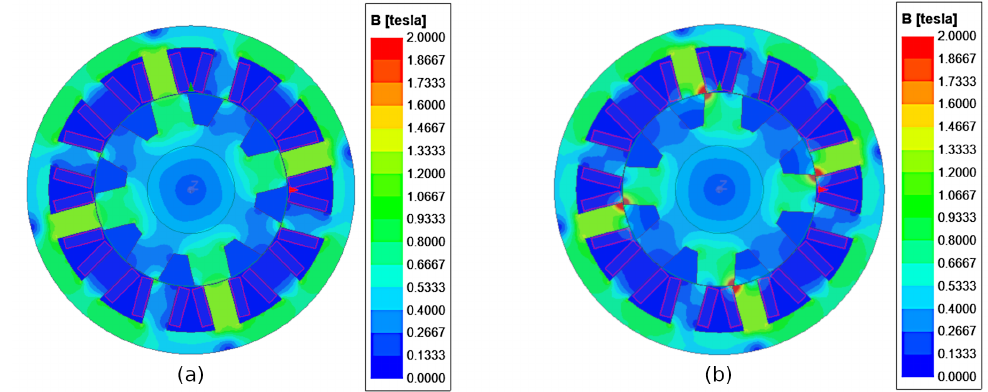
Figure 4. Magnetic flux distribution of conventional SRM: ( a ) aligned poles and ( b ) unaligned poles.